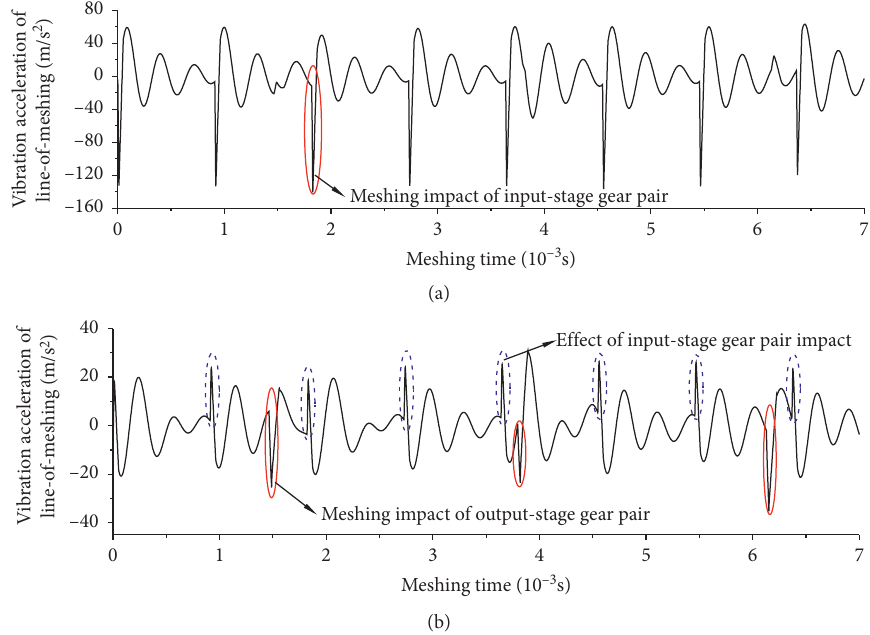
Figure 18: Time-domain diagram of two-stage helical gear transmission under excitation of meshing impact at 3,000 rpm, (a) the input- stage gear pair, (b) the output-stage gear pair.